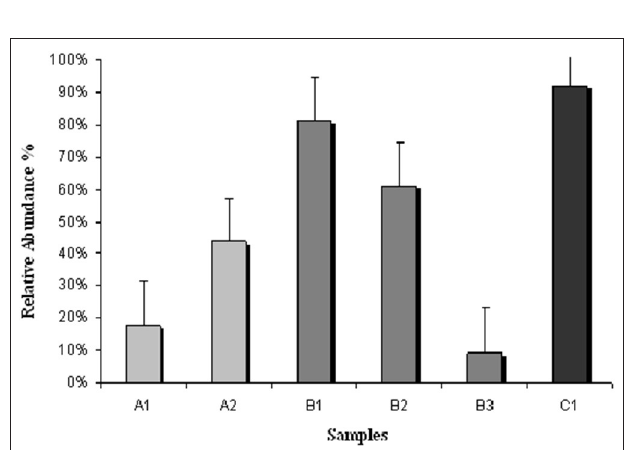
FIGURE 5 | Relative abundance of Serpulidae in the Polychaeta assemblage by sampling period.